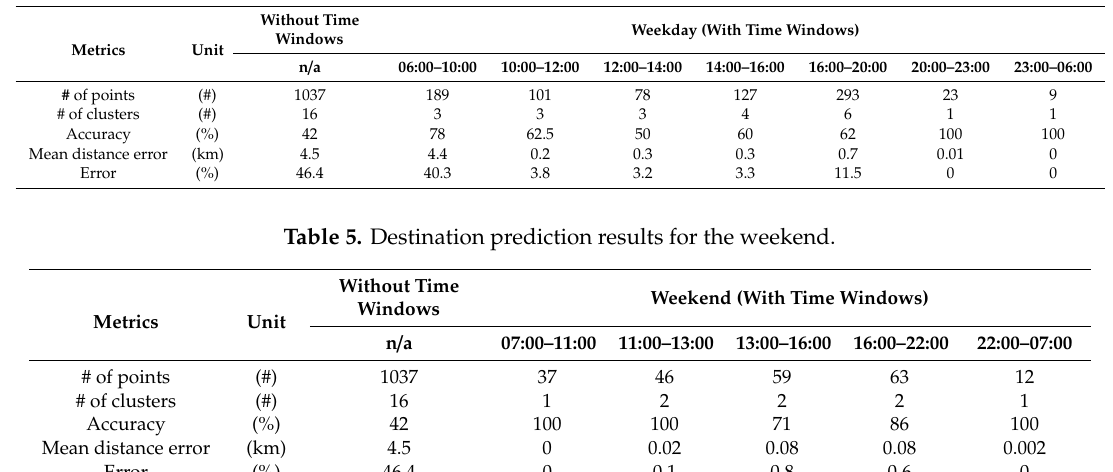
Table 4. Destination prediction results for a weekday.